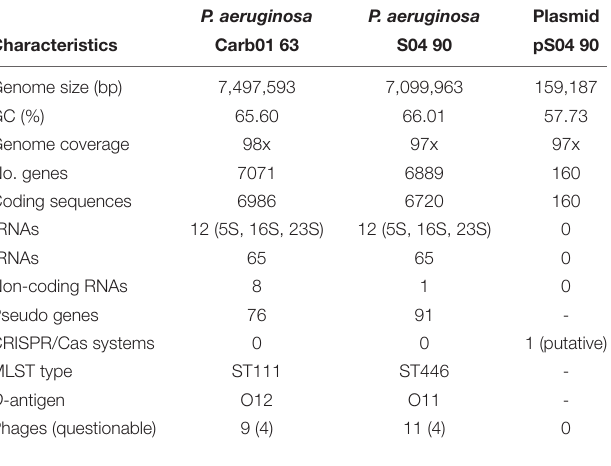
TABLE 2 | Characteristics of the chromosomes of Carb01 63 and S04 90 and pS04